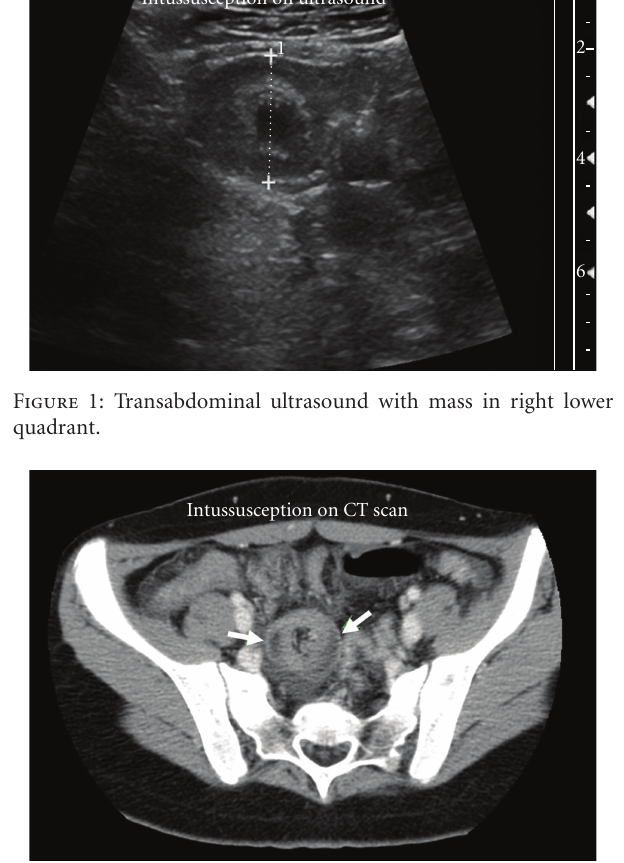
Figure 2: CT scan of abdomen showing intussuscepted